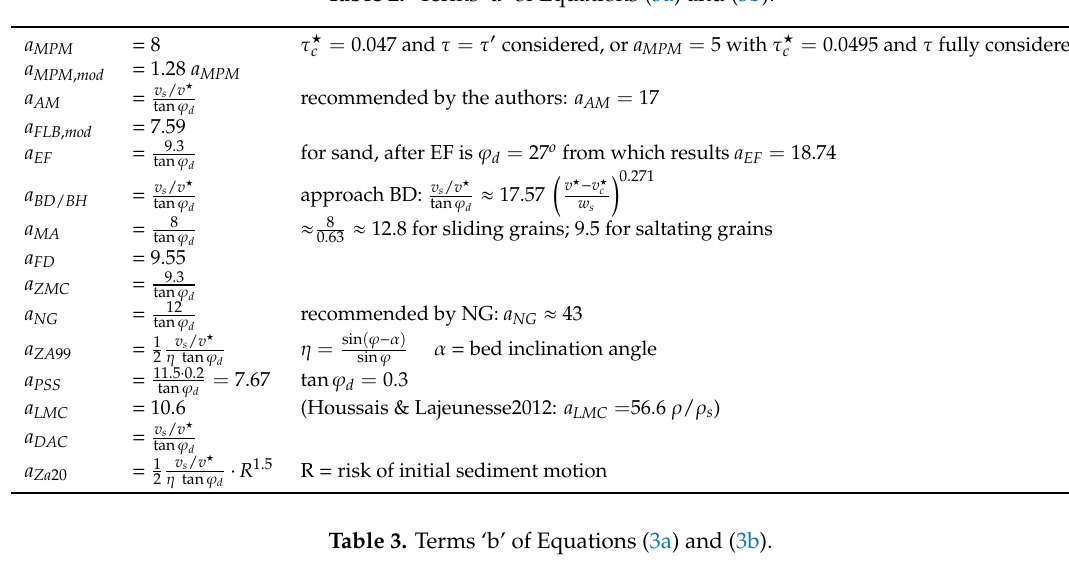
Table 2. Terms ‘a’ of Equations (3a) and (3b).